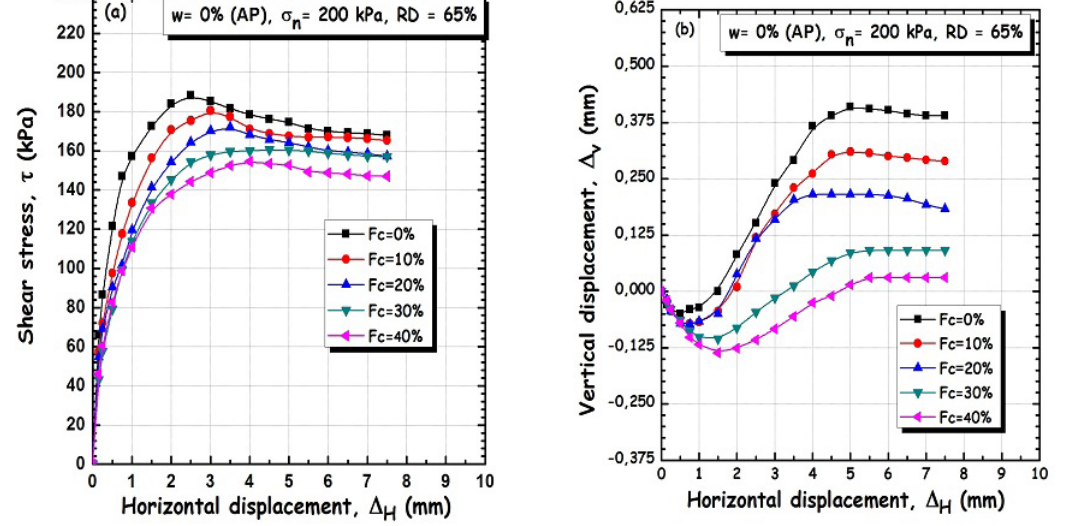
= 200 kPa): (a) variation of the shear n